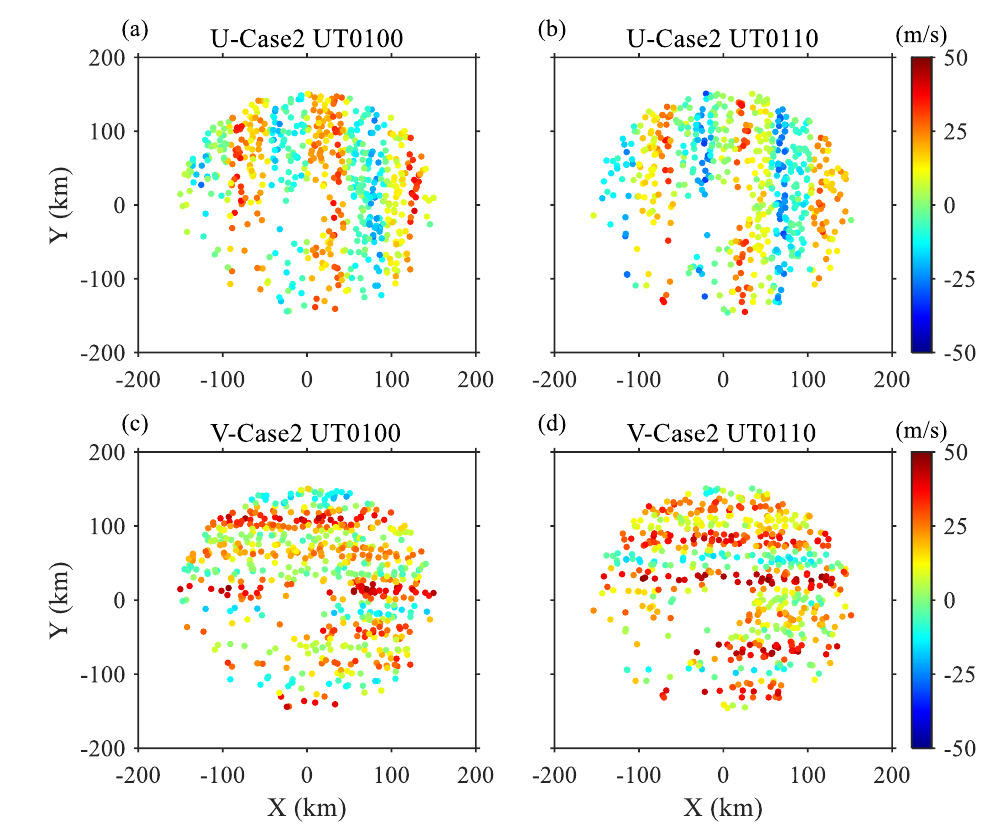
Figure 3. Example of the artificial prescribed constructing zonal ( a , b ) and meridional ( c , d ) winds with GWs for Case 2 at UT0100 and UT0110 within an interval of ± 5 min at heights of 88.5–91.5 km in June 2012.